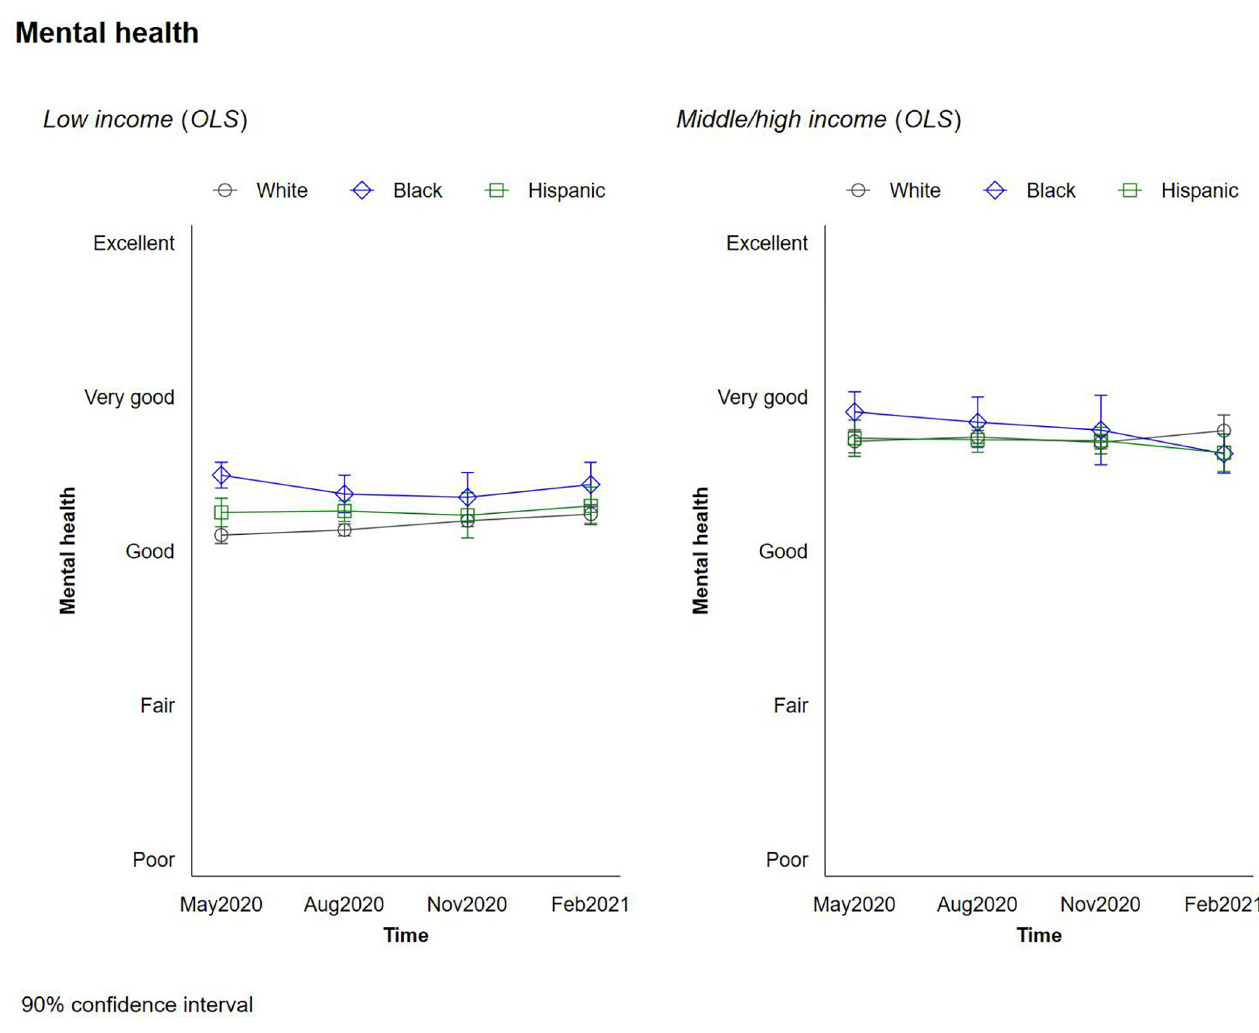
Fig 4. Changes in mental health by race and